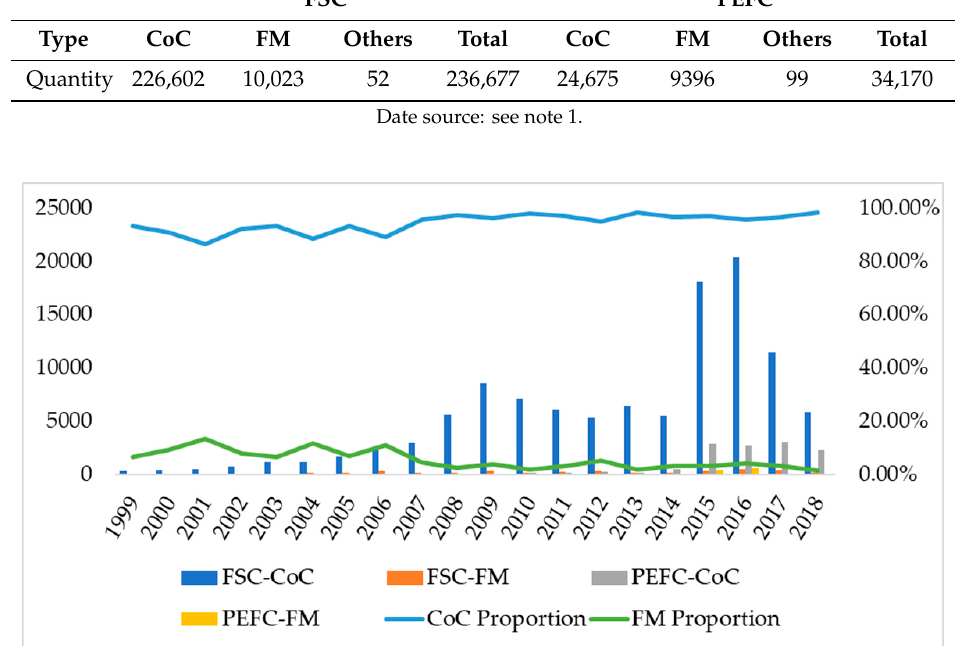
Figure 1. The number and proportion of forest management (FM) and chain of custody (CoC) certifications of FSC and PEFC from 1999 to 2018. Date source: see note 1.